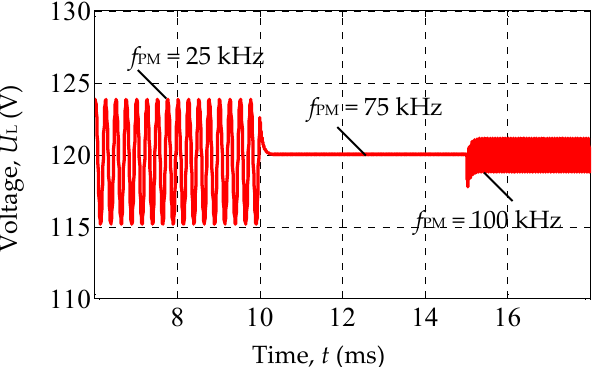
Figure 8. Voltage ripple on the solar panel at different frequencies of current change.